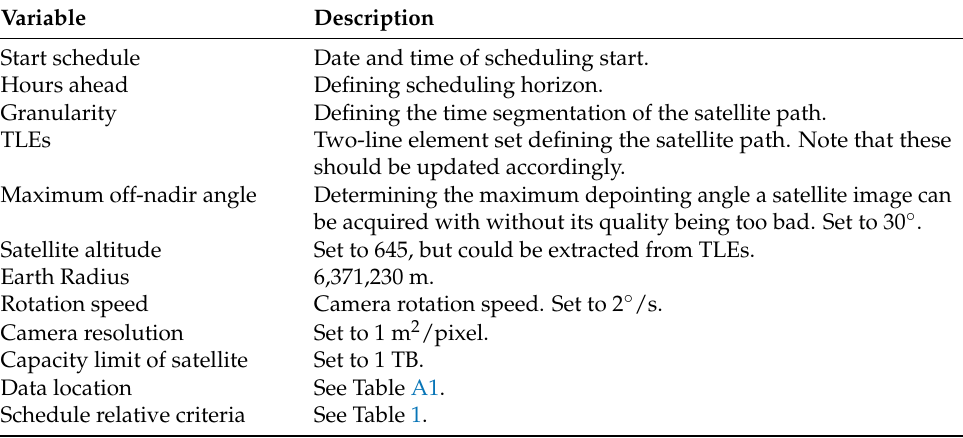
Table A2. Presentation of all inserted information in the